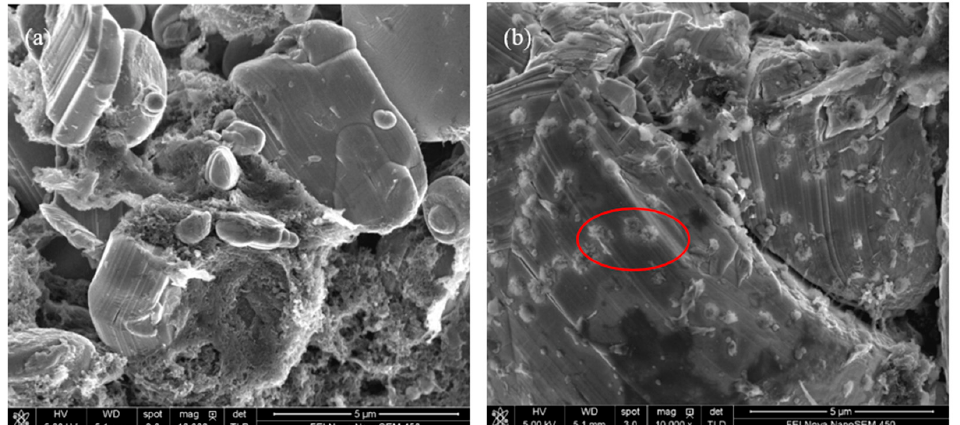
Figure 5. Cycle performance of full-cell at charge/discharge rate of 1 °C at 45 °C: ( a ) Capacity retention rate; ( b ) EIS Nyquist plots of LiCoO 2 vs. Li + /Li EIS with a different electrolyte before and after the